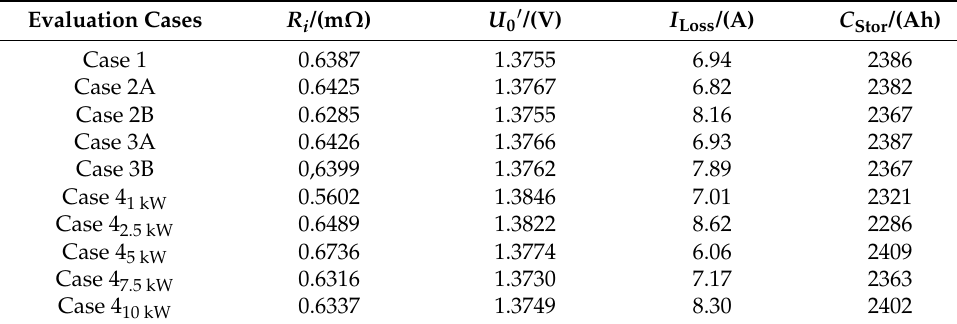
Table 4. Optimal model parameters for universally valid parametrization.